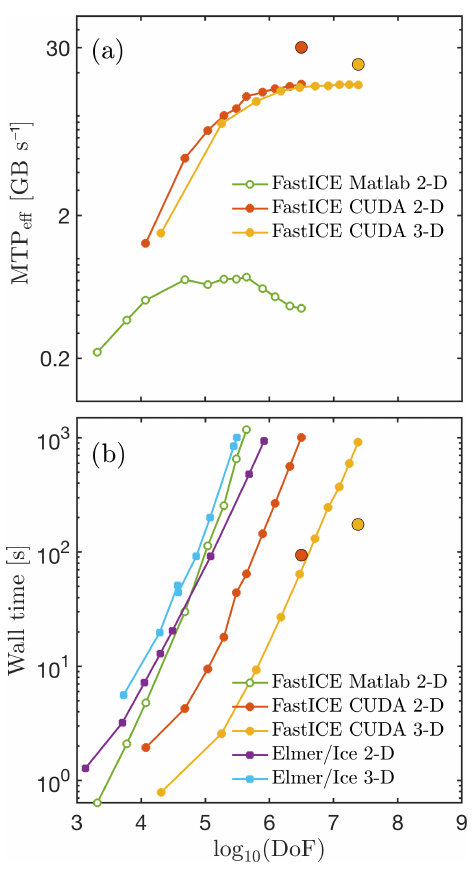
Figure 16. Residual evolution and convergence efficiency of the Figure 17. Performance evaluation of the FastICE mechanical 2-D FastICE GPU-based implementation for a numerical grid reso- solver in terms of (a) the effective memory throughput MTP eff in lution of 511 × 127 grid points targeting a relative non-linear tol- GB per second and (b) the wall time (in seconds) to converge the erance of tol nonlin = 1 e − 8. (a) Relative total non-linear residu- Stokes solver to a relative non-linear tolerance of tol nonlin = 10 − 8 . ,f T ) as a function of non-linear iterations and als f = max (f P ,f v We report the results obtained using a 2-D CPU-based single-core i (b) the non-linear iteration count as a function of the damping pa- vectorised MATLAB implementation of FastICE, a 2-D and 3-D rameter ν (Eq. 19). GPU-based CUDA C implementation of FastICE, and a 2-D (di- rect) and 3-D (iterative) solver within the Elmer/Ice FEM single- core CPU-based model. The CPU codes are executed on an Intel i7 4960HQ CPU processor with 8GB of RAM, and the GPU codes are launched on a Nvidia Titan X (Maxwell) GPU with 12GB of on-board memory. All the computations are performed in double- precision arithmetic, with the only exception for the two single- precision GPU-based runs depicted with larger red (2-D) and or- ange (3-D) symbols. The single-core FastICE CPU MATLAB and Elmer/Ice results are shown for reference; they are not meant for performance comparison because we did not enable multi-threading in MATLAB and did not have access to a parallel version of